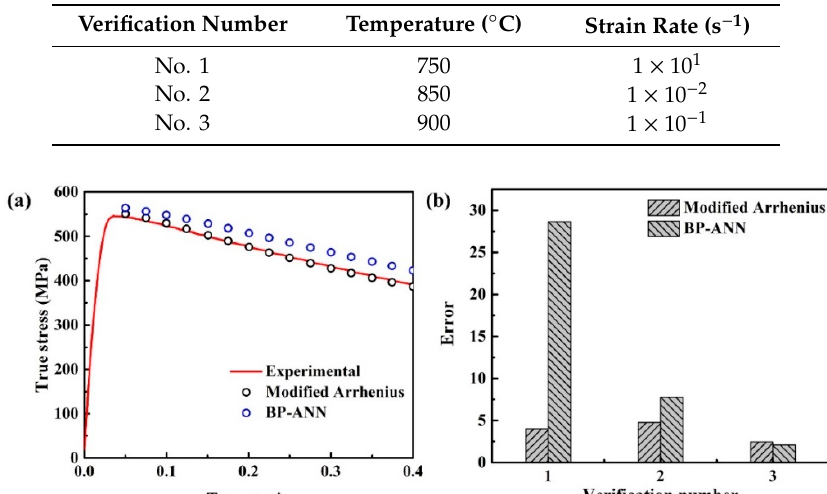
Table 6. The excluded conditions in the cross-validation.